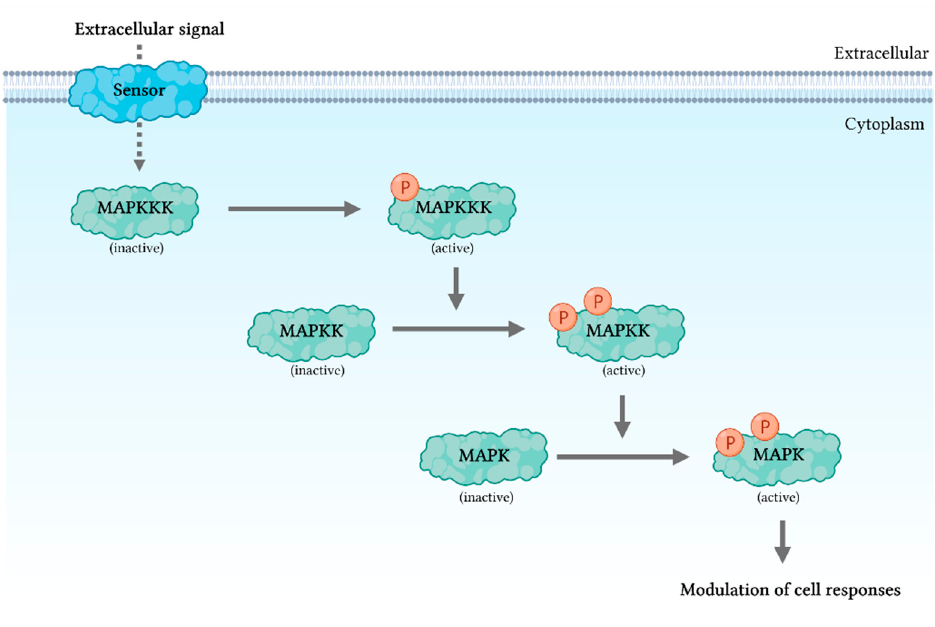
Figure 1. Schematic representation of MAPK signal transduction cascade. A membrane receptor perceives an extracellular signal. The sensor then activates the MAP kinase module (MAPKKK activates MAPKK, which in turn activates the MAPK) by phosphorylation. That may occur via different routes and intermediate steps. The modulation of cell responses by the active MAPK may activate different protein kinases or cytosolic components. Furthermore, the activated MAPK may translocate to the nucleus and regulates transcription factors. Arrows indicate activation.